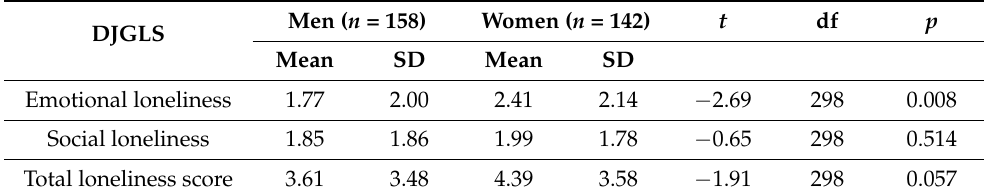
Table 5. DJGLS scores with regard to gender. DJGLS